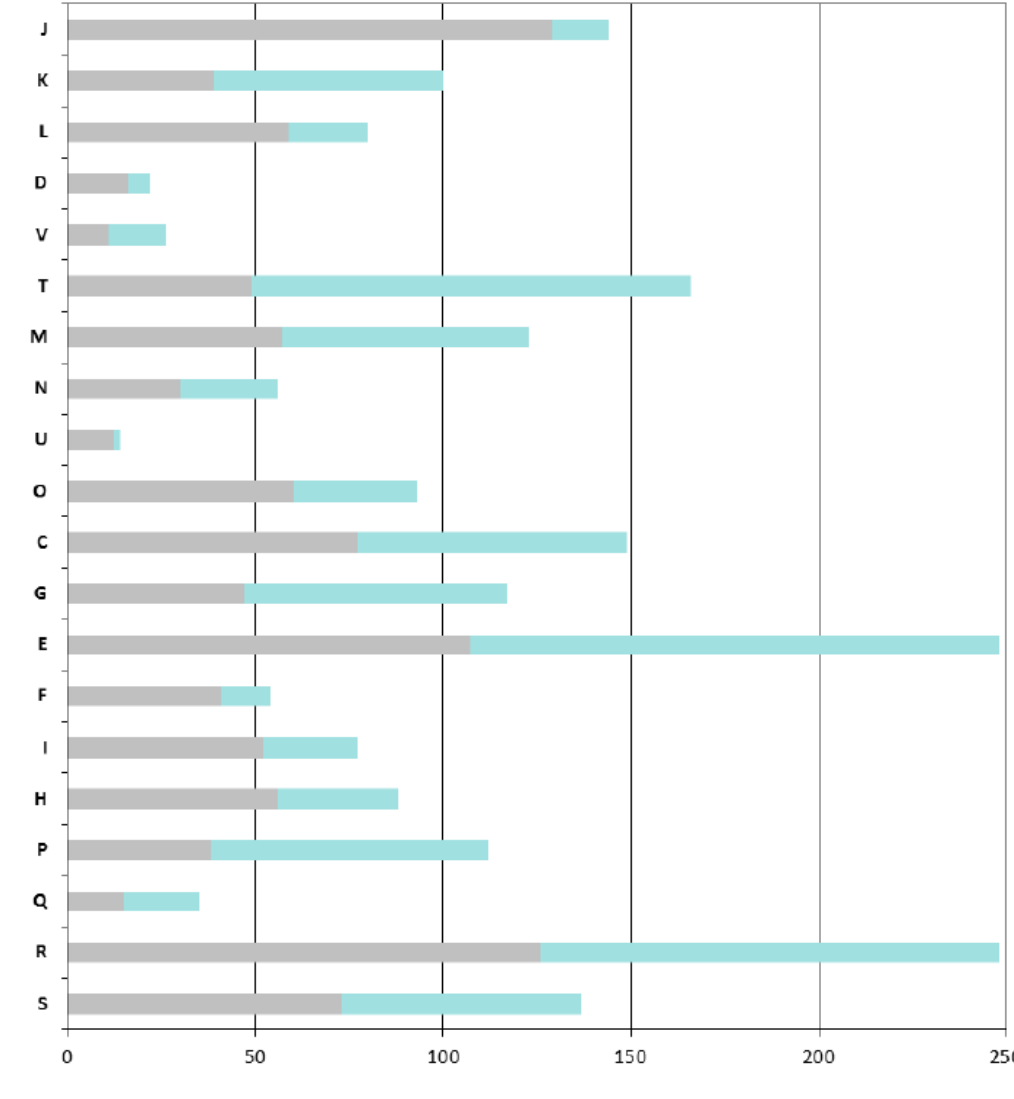
Figure 4. COGs functional classification of the Azospirillum orthologous groups. Bars indicate the numbers of orthologous groups for each COG retrieved from the MaGe platform for the A. lipoferum 4B orthologues. For each bar, the grey part represents the number of orthologous groups found in the ancestral ( Azospirillum-Rhodospirillum) orthologous groups, the green part represents the number of orthologous groups that are unique to the Azospirillum genus. COG: J, Translation, ribosomal structure and biogenesis; K, Transcription; L, Replication, recombination and repair; D, Cell cycle control; V, Defence mechanisms; T, Signal transduction mechanisms; M, Cell wall, membrane envelope biogenesis; N, Cell motility; U, Intracellular trafficking and secretion; O, Postranslational modification and chaperones; C, Energy production and conversion; E, Amino acid transport and metabolism; F, Nucleotide transport and metabolism; G, Carbohydrate transport and metabolism; H, Lipid transport and metabolism; I, Coenzyme transport and metabolism; P, inorganic ion transport and metabolism; Q, Secondary metabolites biosynthesis, transport and catabolism; R, General function prediction; and S, Function